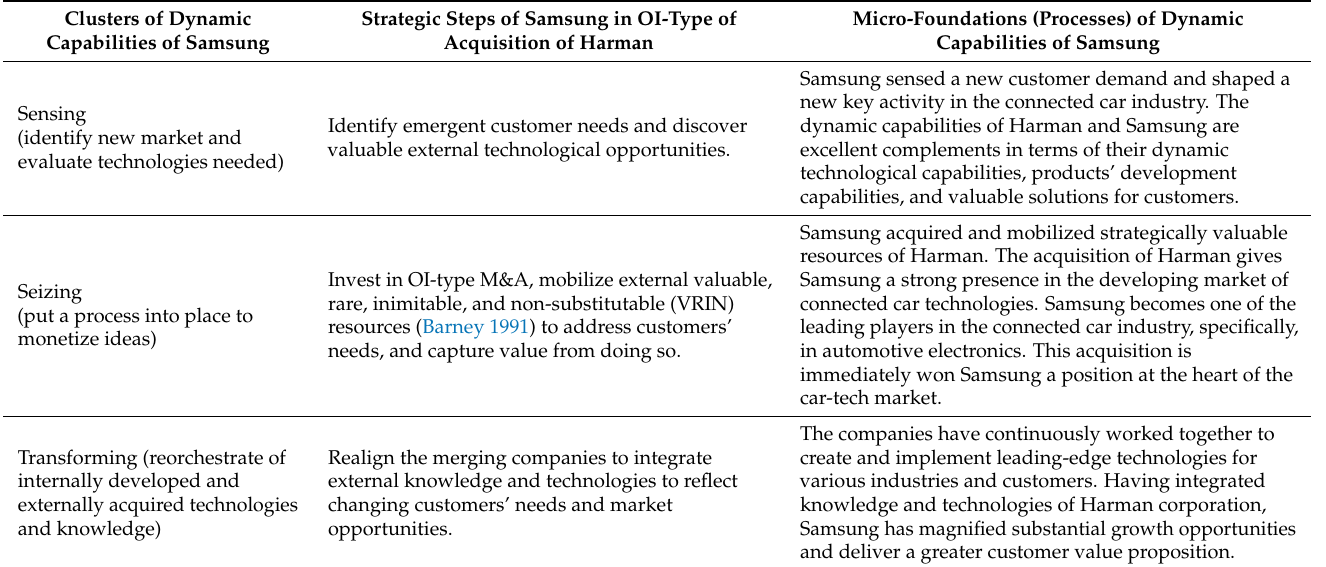
Table 1. Clusters of dynamic capabilities of Samsung and their micro-foundations in the process of the acquisition of